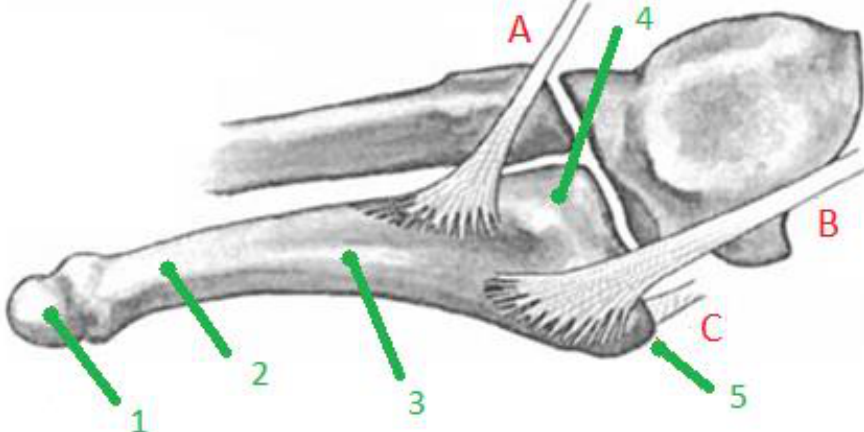
Figure 2. Anatomy of the 5th metatarsal bone: (1) head; (2) neck; (3) diaphysis; (4) base; (5) tuberosity. ( A ) peroneus tertius (also fibularis tertius) muscle; ( B ) peroneus brevis (also fibularis brevis) muscle; ( C ) plantar fascia.